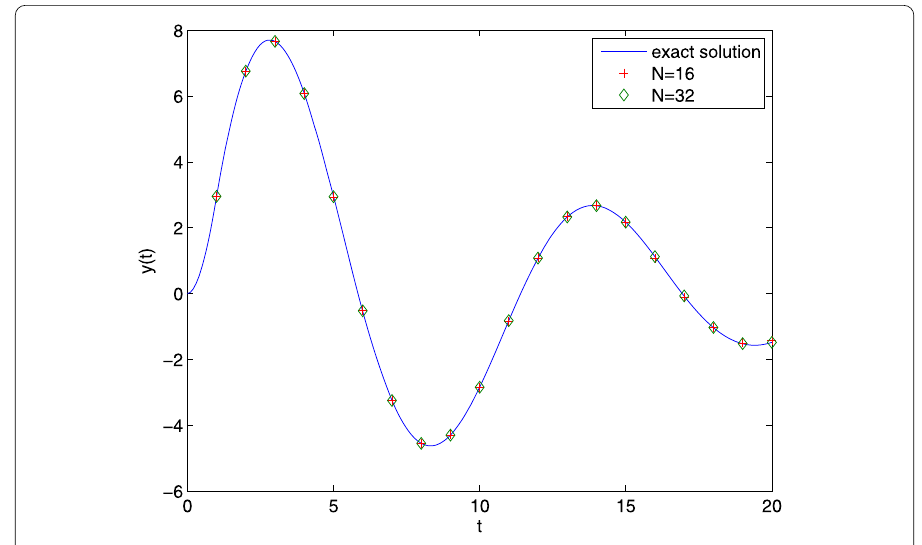
Figure 1 Comparison of the numerical solution with N = 16,32 using our method and the exact solution